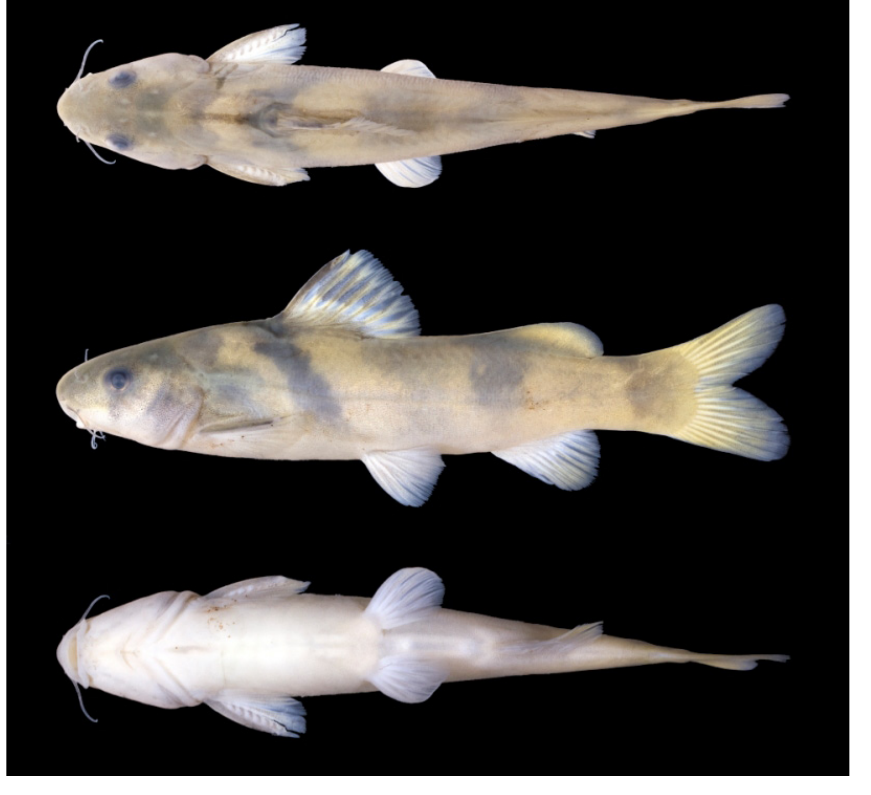
Image 2. Reproduced from Ng (2009): Batasio merianiensis , UMMZ 248780, 75.7mm SL; dorsal, lateral and ventral views